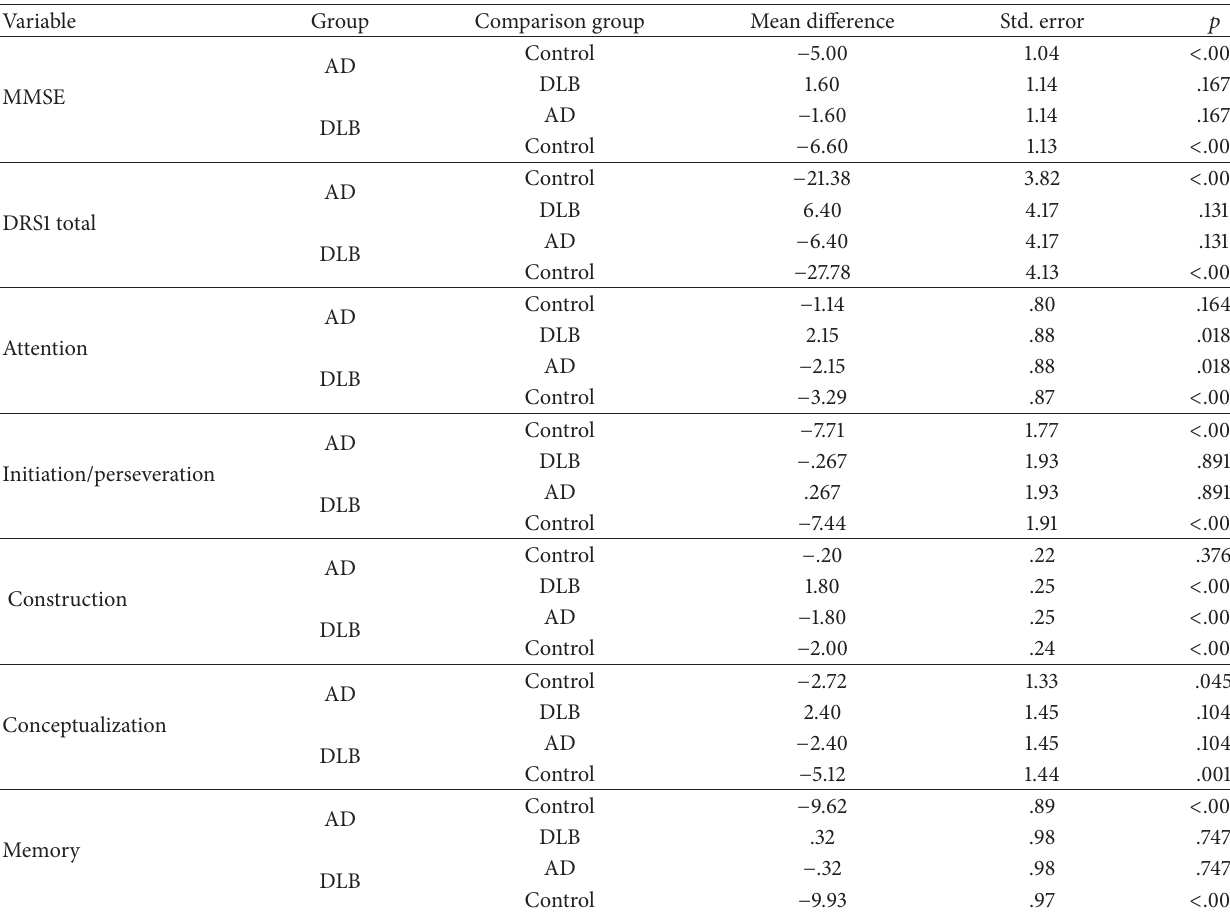
Table 2: Post hoc group comparisons (i.e., control, DLB, and AD) on global measures of